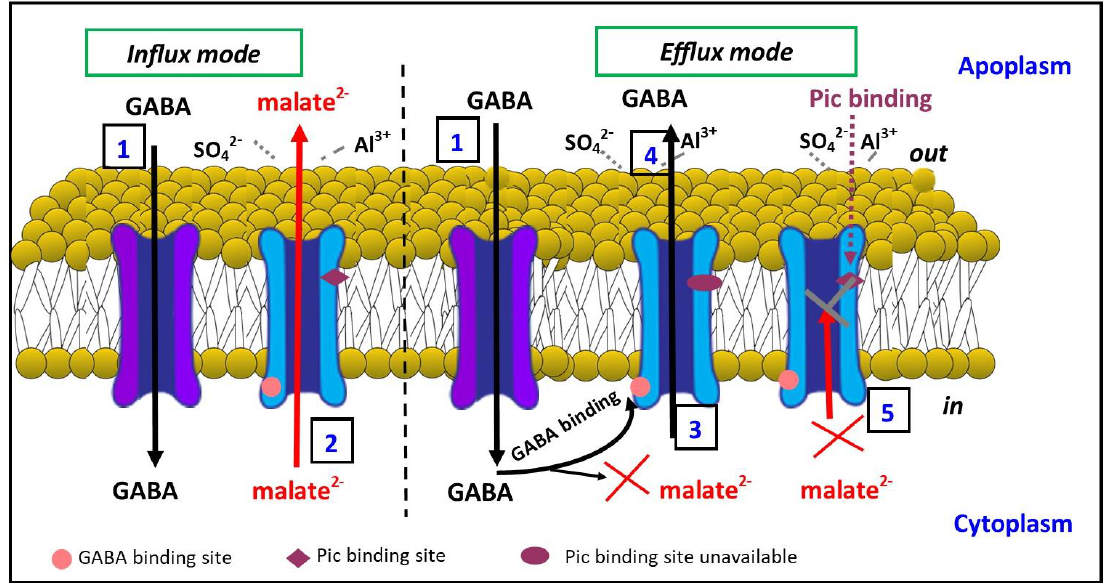
Figure 7. Schematic of GABA and malate transport through TaALMT1. In the influx mode, GABA transport can occur from the external side of the membrane via GABA transporters ( 1 ). In the presence of aluminium (Al 3+ ) or transactivating anions such as sulphate (SO 42 − ), malate is effluxed ( 2 ) into the apoplasm across the plasma membrane via TaALMT1. GABA binding to the GABA binding site ( 3 ) on TaALMT1 is proposed to cause a conformational change that allows GABA efflux ( 4 ) but prevents malate efflux via TaALMT1. Picrotoxin (PTX) binding to the malate-transporting conformation of TaALMT1 blocks malate transport ( 5 ). GABA influx transporter (purple); malate/GABA efflux transporter TaALMT1